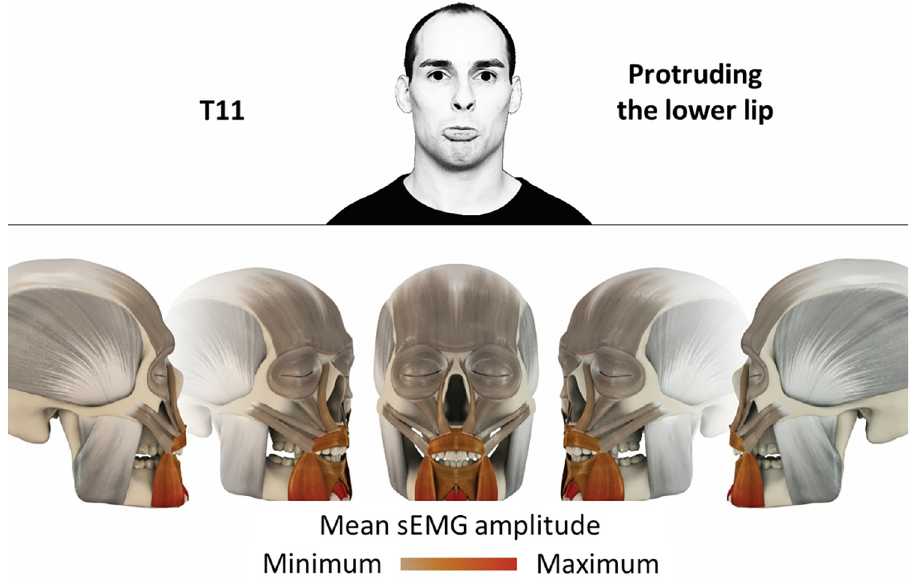
Fig 12. Color-coded facial muscle activation pattern of task T11. Protruding lower lip. Animation by Jonas Laustro¨er.